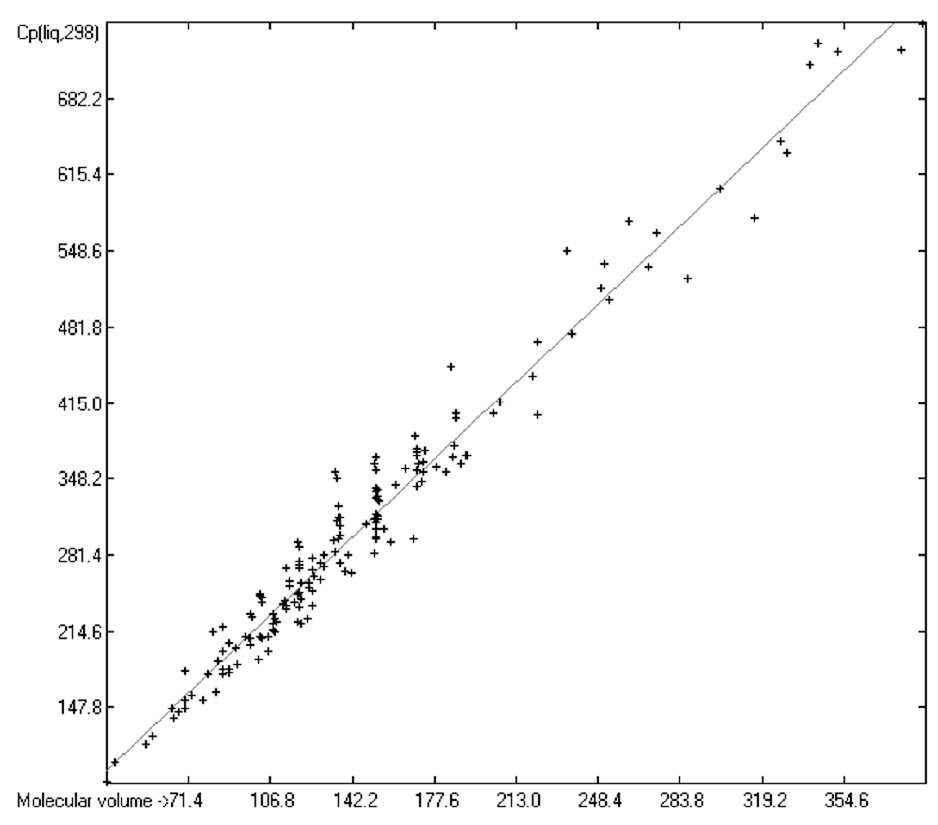
Figure 8. Correlation of molecular volumes with Cp(liq) at 298.15 K of monools and monoacids. (N = 164, R 2 = 0.9685, σ = 22.91 J/mol/K, MAPD = 6.04%, regression line: intercept = 23.3101, slope = 1.9282, Value range from 81.92 to 748.0 J/mol/K). Table 6. Molecular volumes Vm (in A 3 ), experimental and Equation (3)-calculated Cp(liq.298) (in J / mol / K) of 164 monools and